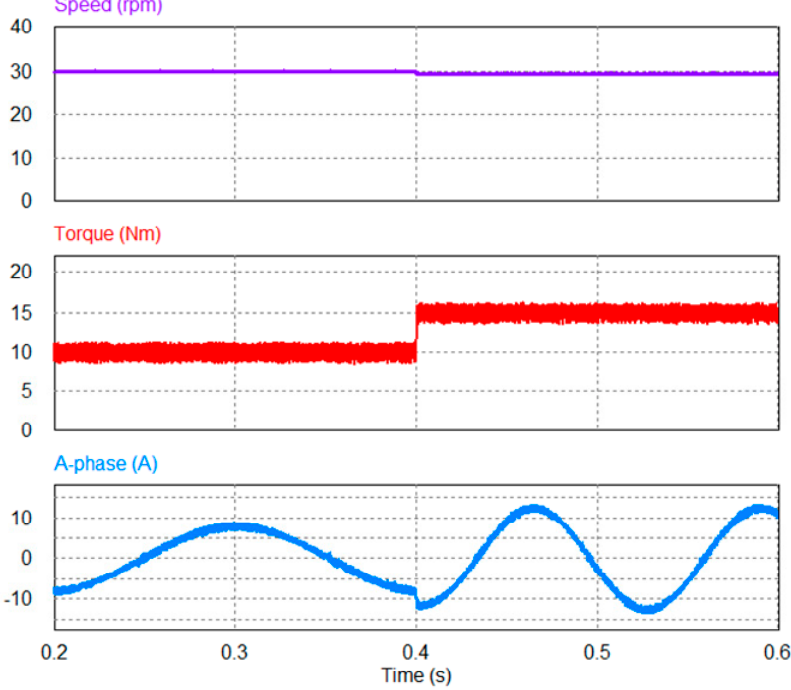
Figure 7. Simulation results of external load disturbance for the proposed CFTR-DTC with interleaving carriers at 30 rpm.